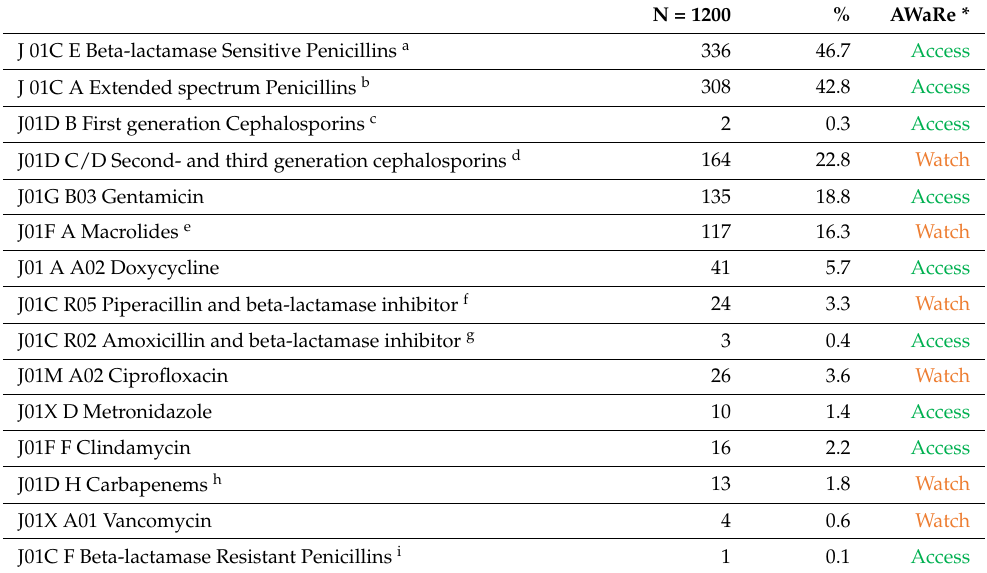
Table 2. Antibiotic prescription rates in 720 patients according to categories of antibacterial drugs and the AWaRe